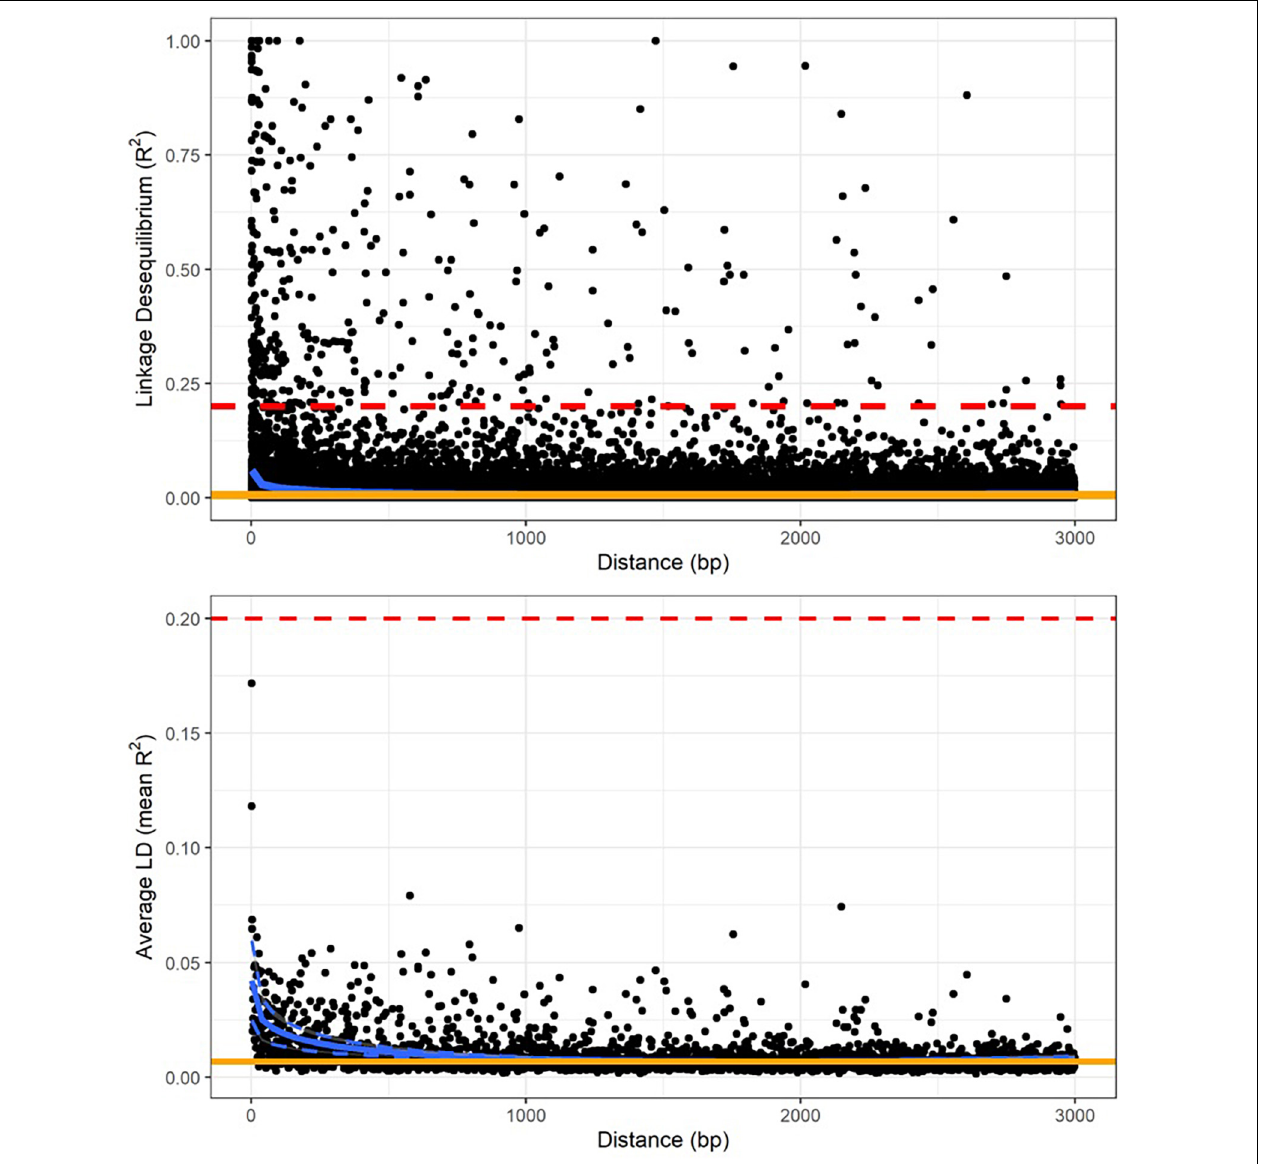
FIGURE 4 | Linkage disequilibrium decay over genetic distance on scaffold 1, calculated on the quality-filtered SNP dataset, minus king tarakihi specimens. The horizontal red dashed line shows the threshold of 0.2 that is commonly applied to identify independent degradation of nucleotide sites. The orange line is the background level of linkage disequilibrium (intercept). The blue line is the trend of linkage disequilibrium decay fitted to the plot (minimum and maximum variance in dashed lines for the